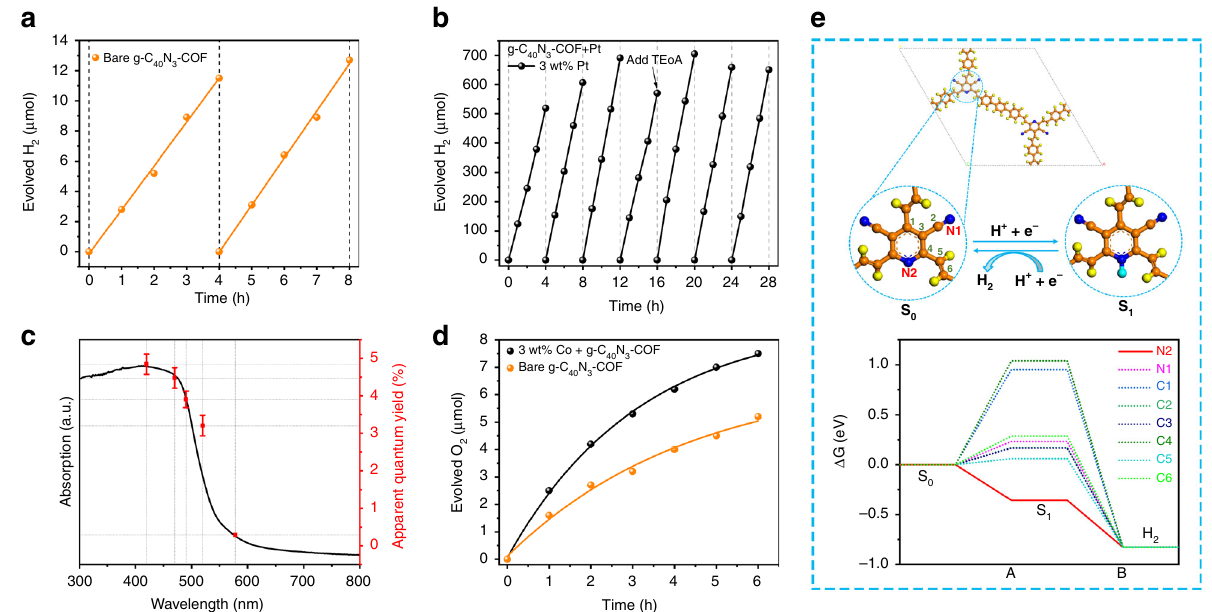
Fig. 6 Photocatalytic hydrogen evolution, oxygen evolution, and AQYs of g-C 40 N 3 -COF. a Time course hydrogen evolution under visible light ( λ > 420 nm) irradiation from H 2 O/TEoA (100 mL/10 mL) mixture using 50 mg bare (metal-free) g-C 40 N 3 -COF monitored over 8 h with evacuation every 4 h (dashed line). b Time course hydrogen evolution under visible light ( λ > 420 nm) irradiation from H 2 O/TEoA (100 mL/10 mL) mixture using 50 mg of 3 wt% Pt modi fi ed g-C 40 N 3 -COF monitored over 28 h with evacuation every 4 h (dashed line). c Absorption spectrum and wavelength-speci fi c apparent quantum yield (AQY) on H 2 evolution measured with monochromatic LED light of wavelengths at 420, 470, 490, 520, and 578 nm, respectively, using 50 mg of 3 wt% Pt-modi fi ed g-C 40 N 3 -COF in H 2 O/TEoA (100 mL/10 mL) mixture. d Time course oxygen evolution from water containing 0.01 M silver nitrate as an electron acceptor under visible light ( λ > 420 nm) by 3.0 wt% Co-loaded and unmodi fi ed g-C 40 N 3 -COF, respectively. La 2 O 3 (0.2 g) was used as a buffer. e Top: reaction cycles and active sites for H 2 evolution from water (C orange, N blue, H in COF: yellow, H from water: light blue). Bottom: free-energy variations for H 2 evolution for each active site as labeled. The error bar represents the standard deviation from the repeated experiment after three